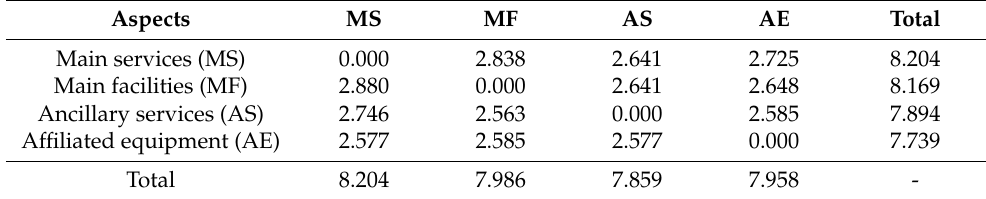
Table 2. The original influence matrix.